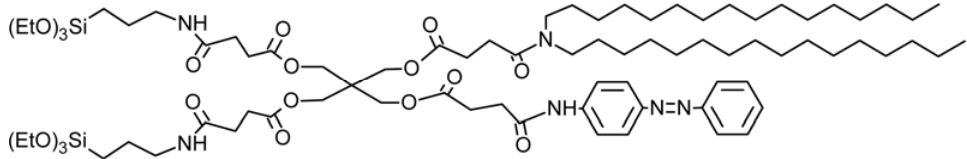
Figure 41. Azobenzene contained organoalkoxysilylated